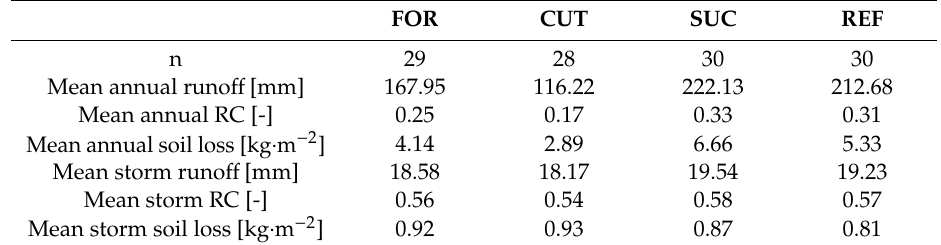
Table 11. Descriptive statistics of standardized modeling results for individual land-management categories: (FOR)ested, (CUT)-down, (SUC)cession and (REF)orested.